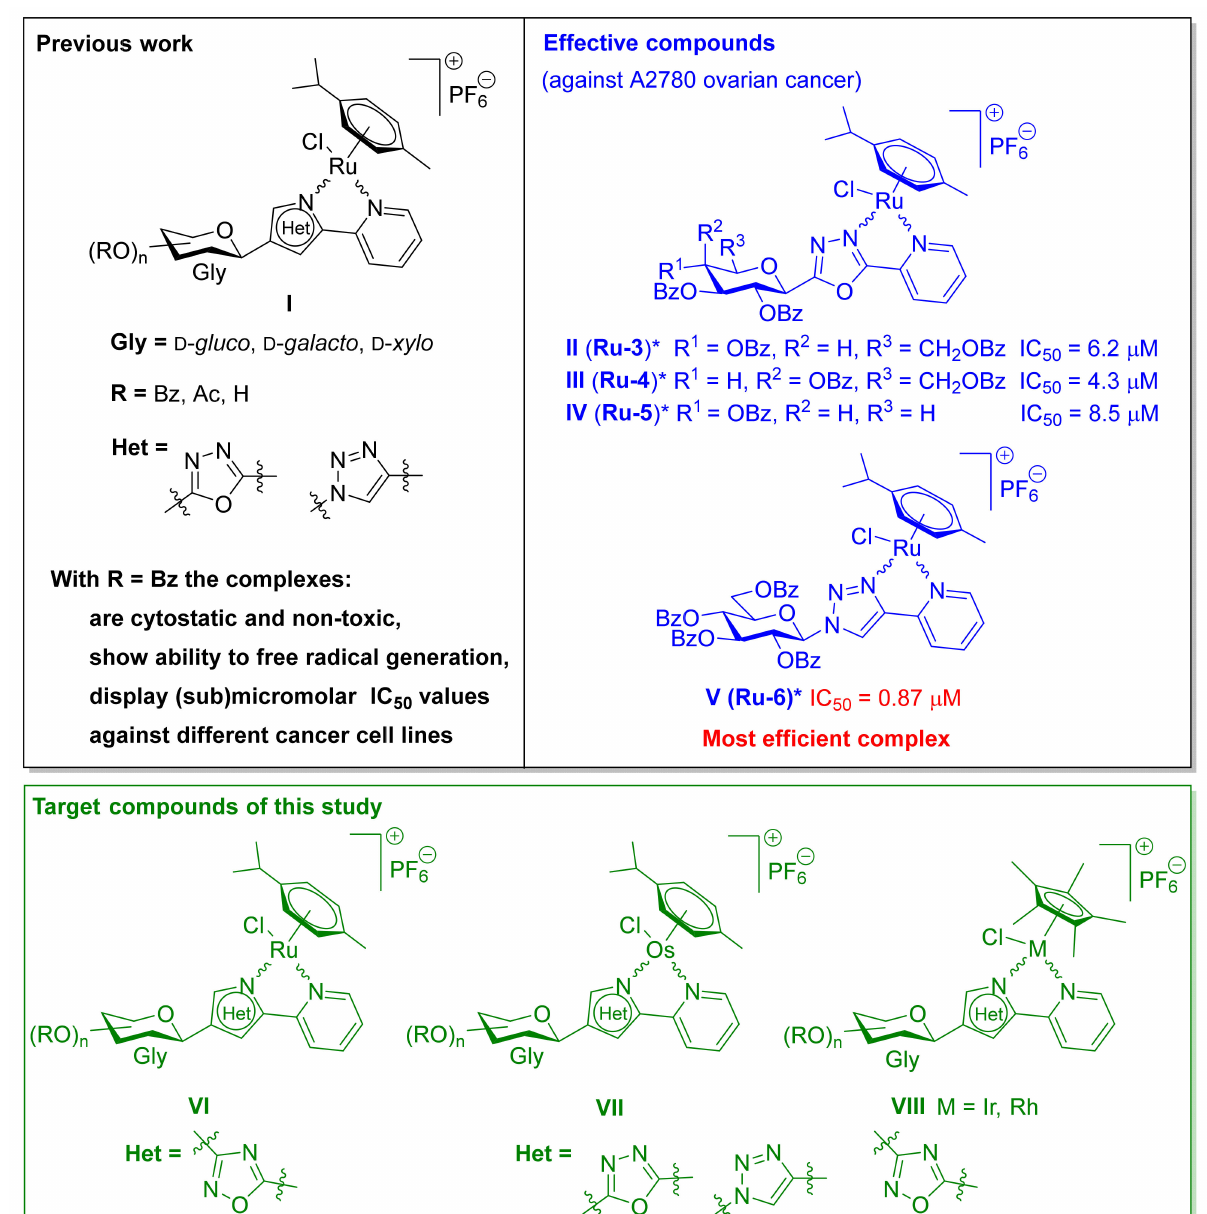
Figure 1. Highlights of our recent study and target compounds of this work. (* To maintain a uniform numbering scheme, these compounds will appear as Ru-3–Ru-6 in this paper, referring to the structural similarities of the complexes with other